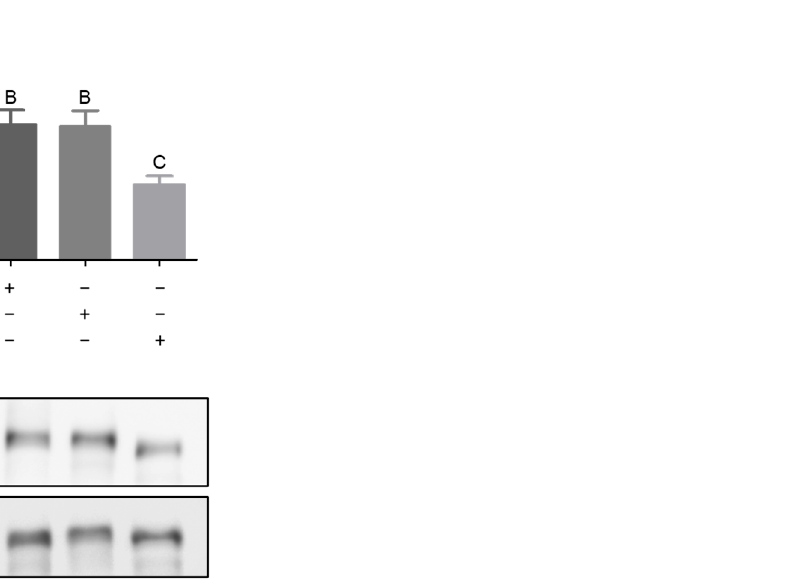
Figure 2. Zinc induces EGFR phosphorylation. The effect of EGF, zinc (Zn) and pyrithione (Pyr) or SNOC on the tyrosine 1068 phosphorylation of the EGFR is shown. A549 cells were stimulated for 60 min with EGF (25 ng/mL), zinc (50 µM) and pyrithione (0.5 µM) or SNOC (2 mM) and phosphorylation effects were quantified by Western blotting. Data of n = 12 independent experiments are shown as means + SEM ( a ). One representative Western blot is presented ( b ). Statistical significances were calculated with one-way Anova and Tukey’s post-hoc test ( p < 0.05). Means not sharing any letter are significantly different (A–C).